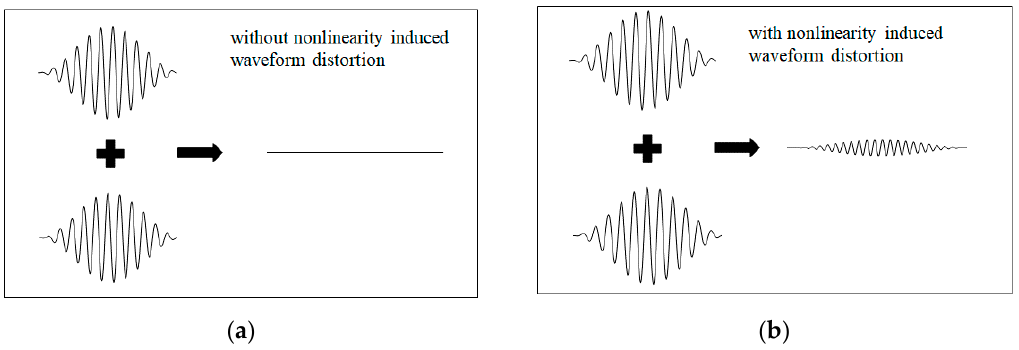
Figure 2. Superposition of two Lamb wave signals in reverse phase; ( a ) without and ( b ) with material nonlinearity induced waveform distortion.